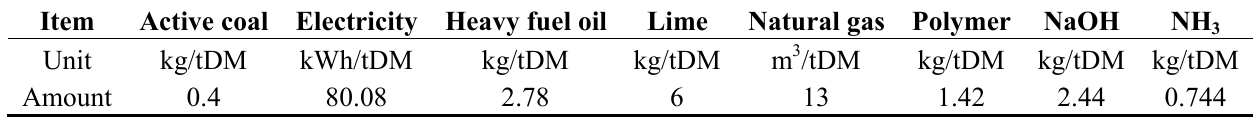
Table A2. Energy and material inputs for mono-incineration